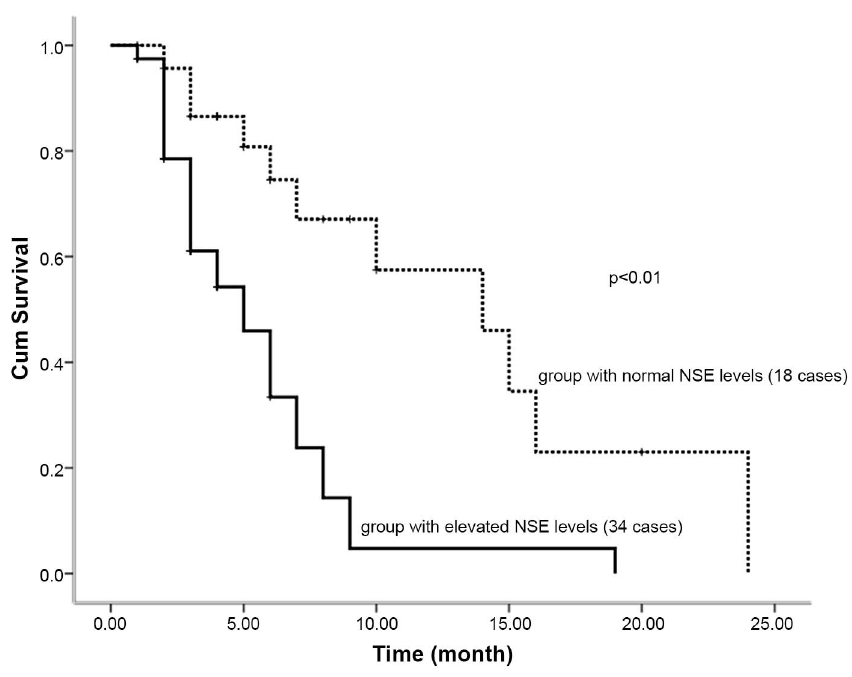
Figure 5. Correlation between NSE level in MM patients and progression-free survival (PFS).